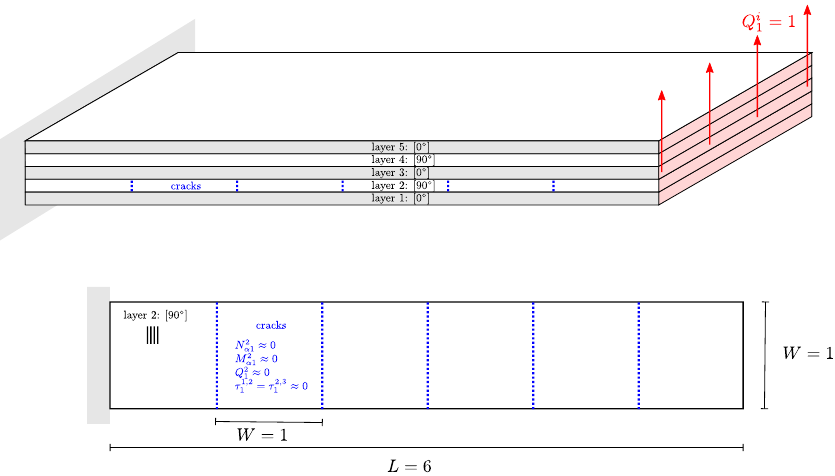
Figure 12. Cracked plate problem.